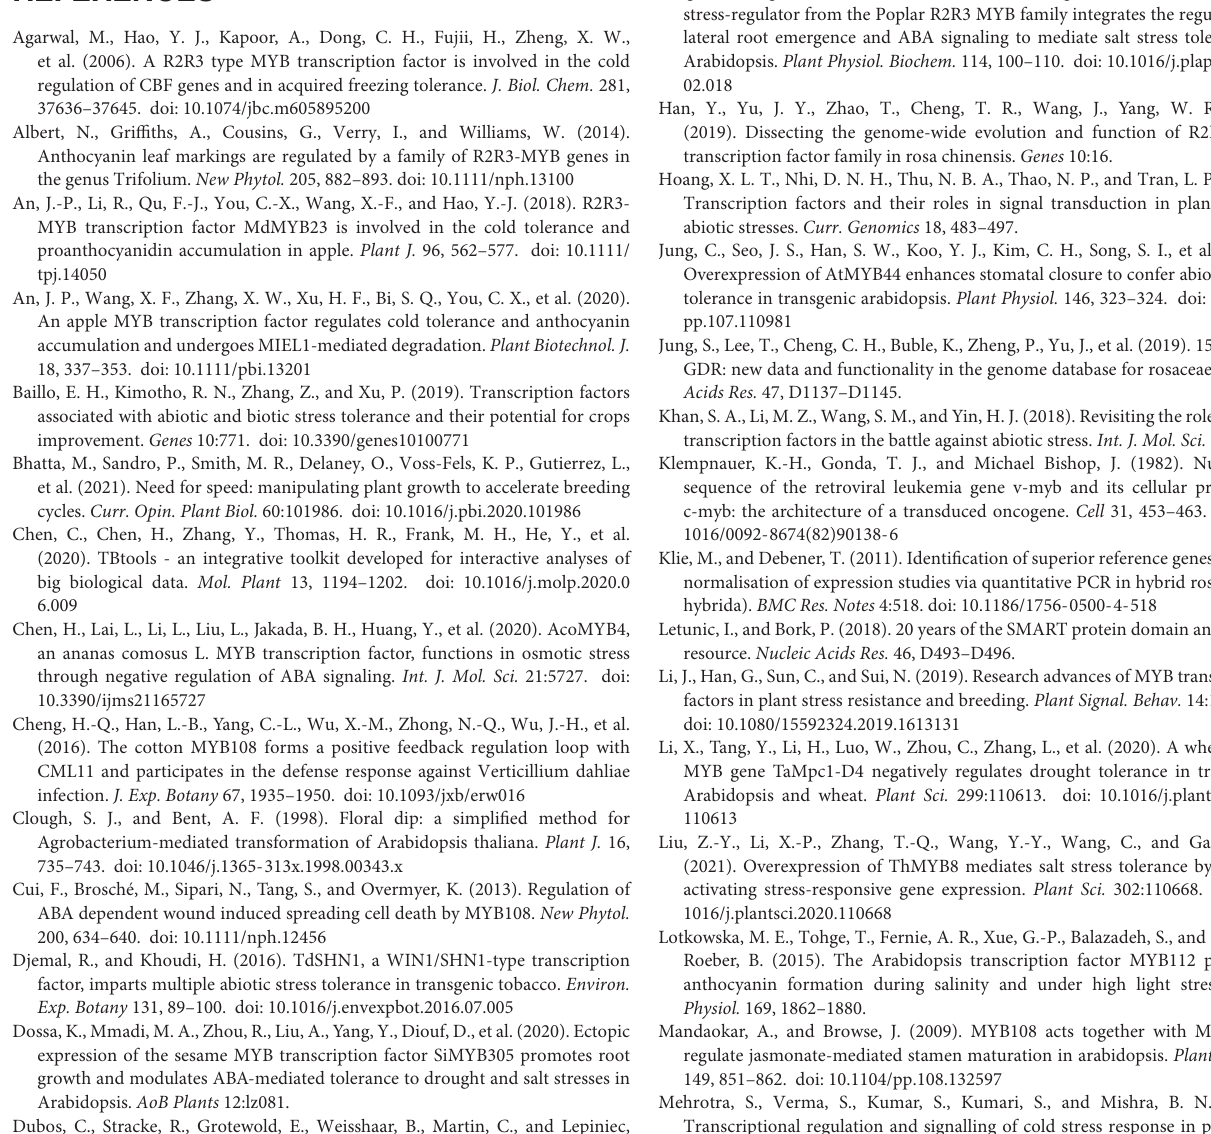
Supplementary Figure 1 | The heatmap indicated row-normalized fragments per kilobase per million (FPKM) of 37 R2R3-MYBs from the RNA-seq database under 25 ◦ C (CK), 4 ◦ C (CT1), –20 ◦ C (CT2) in Rosa multiflora . Supplementary Figure 2 | The phylogenetic tree of R2R3-MYB genes among Rosa multiflora , Rosa chinensis, and Arabidopsis thaliana . Red triangle marked R2R3-MYBs in R. multiflora , green star marked R2R3-MYBs in R. chinensis , and blue circle represented R2R3-MYB s in A. thaliana . Supplementary Figure 3 | The putative regulation network of RmMYB108 after encountering chilling in overexpressed RmMYB108 Arabidopsis . Supplementary Table 1 | The primers names and sequences (5 (cid:48) –3 (cid:48) ) for quantitative real-time polymerase chain reaction (qRT-PCR), reverse-transcriptase polymerase chain reaction (RT-PCR), cloning, overexpression, subcellular localization, and self-activation.